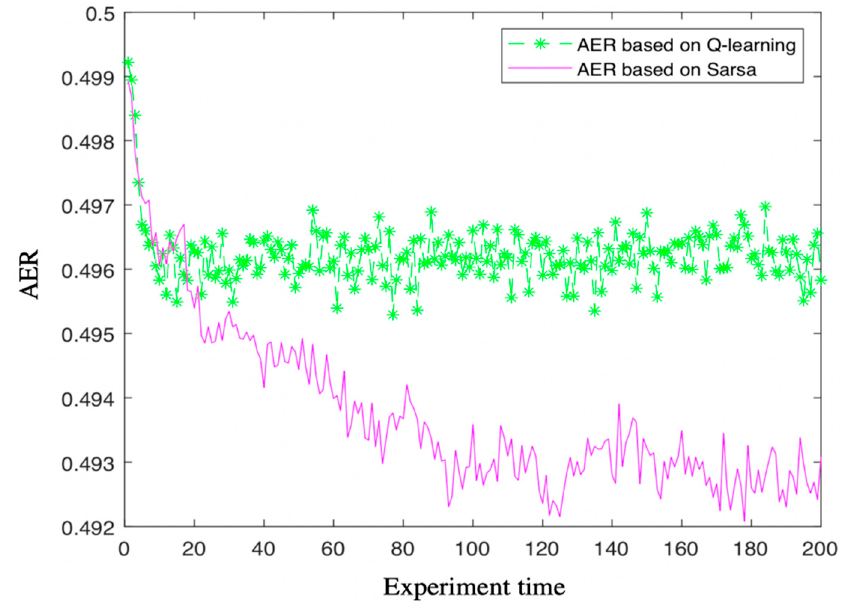
Figure 10. The comparison of AER based on SARSA and Q-learning.